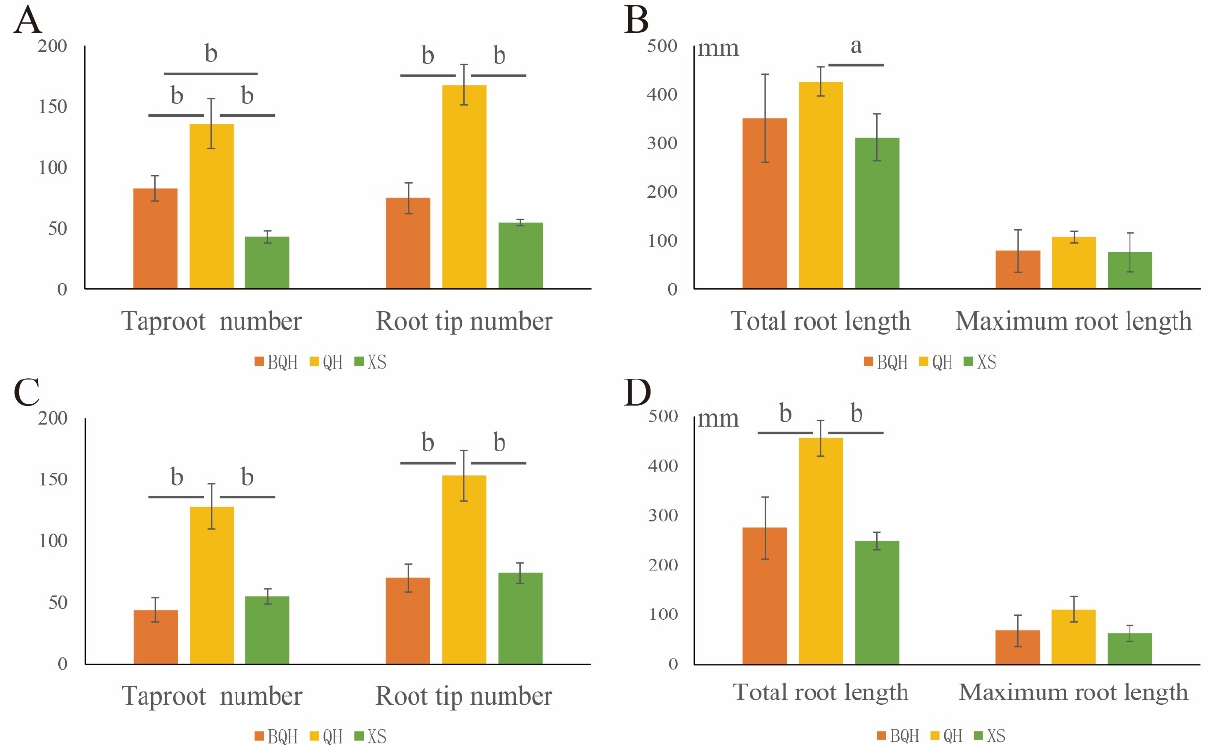
Figure 3. Comparison of the root characteristics among the three cultivars of tree peonies under air layering. ( A ) Comparison of the number of taproots and root tips of three cultivars treated with NAA at 1000 mg/L; ( B ) the total length and maximum root length of the primary roots of three cultivars treated with NAA at 1000 mg/L; and ( C , D ) comparison of the same root characteristics among the three cultivars treated with IBA at 1000 mg/L. BQH: Baoqing Hong; QH: Quehao; XS: Xishi. a indicates significant differences, 0.01 < p < 0.05; and b indicates highly significant differences, 0.01 < p < 0.05.